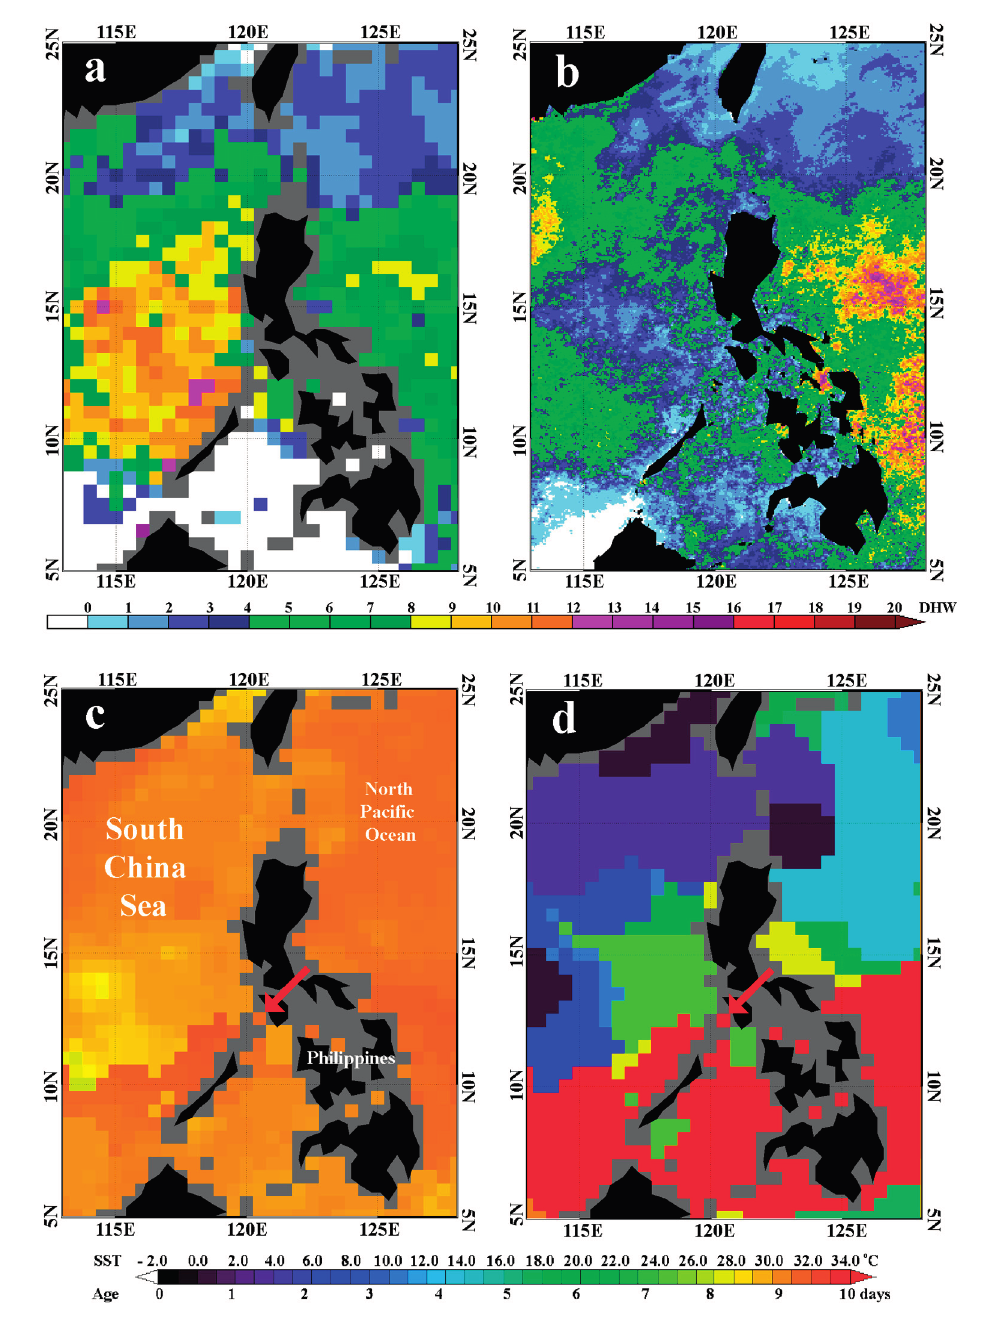
Figure 5. Comparison of CRW products in the South China Sea on 10 July 2014: ( a ) twice-weekly 50-km DHW product and ( b ) daily 5-km DHW product; also shown are ( c ) NESDIS’ twice-weekly 50-km SST analysis ( i.e. , SST composite of 7–10 July 2014) used by the 50-km DHW; and ( d ) the age (in days) of the newest SST retrievals used in the 50-km SST analysis for that region. The overestimation of the 50-km DHW shown in (a) is a result of persistent cloud cover partially demonstrated in the SST analysis (c) and explained by the retrieval ages plotted in (d); red arrows in (c) and (d) point to the pixel whose time series data are displayed in Figure 4. (Dark grey pixels in the 50-km images are land